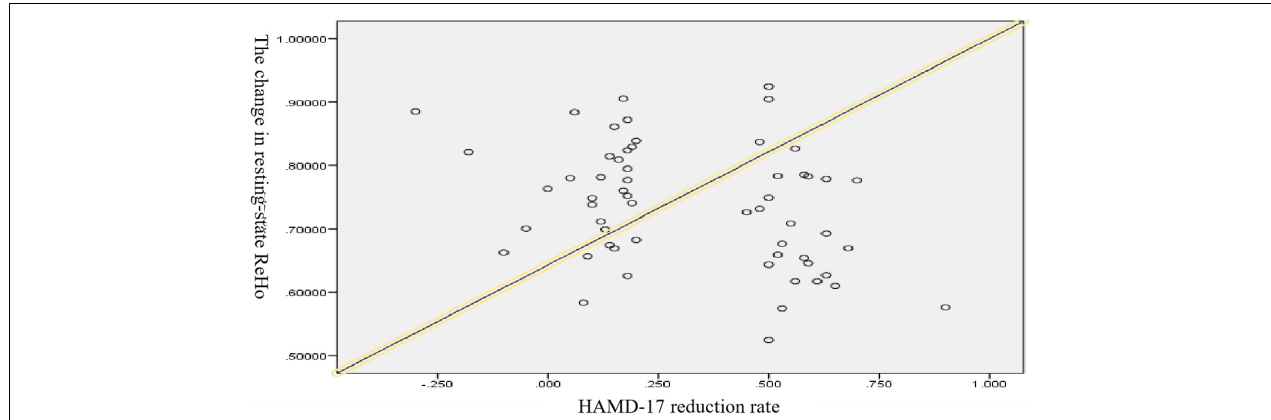
FIGURE 7 | | Scatterplot of major depressive disorder (MDD) based on ReHo and HAMD-17 score reduction rate.